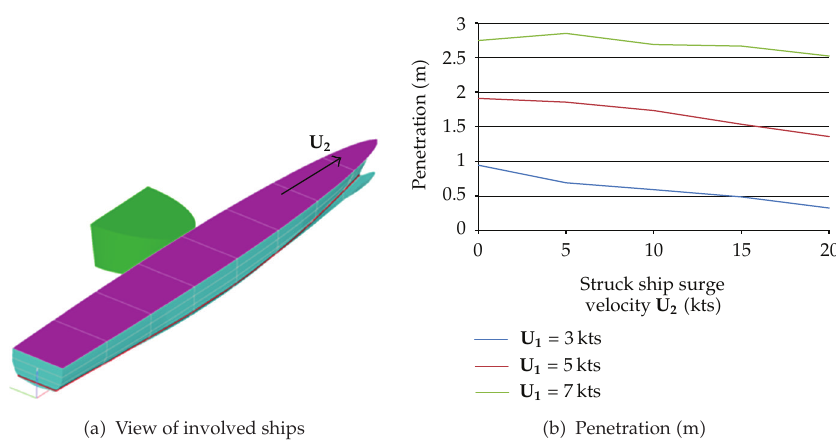
Figure 22: Sensitivity of damage penetration to struck ship surge